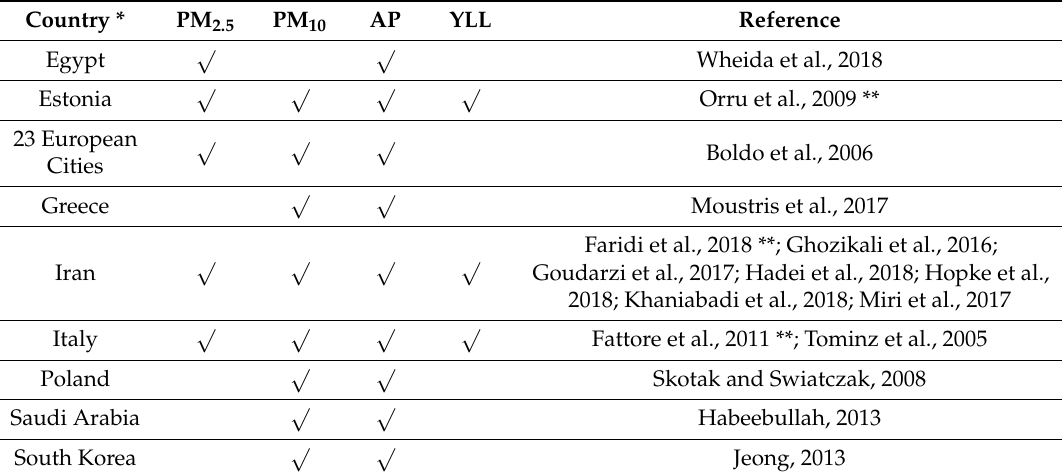
Table 1. International use of the AirQ+/AirQ2.2 model.